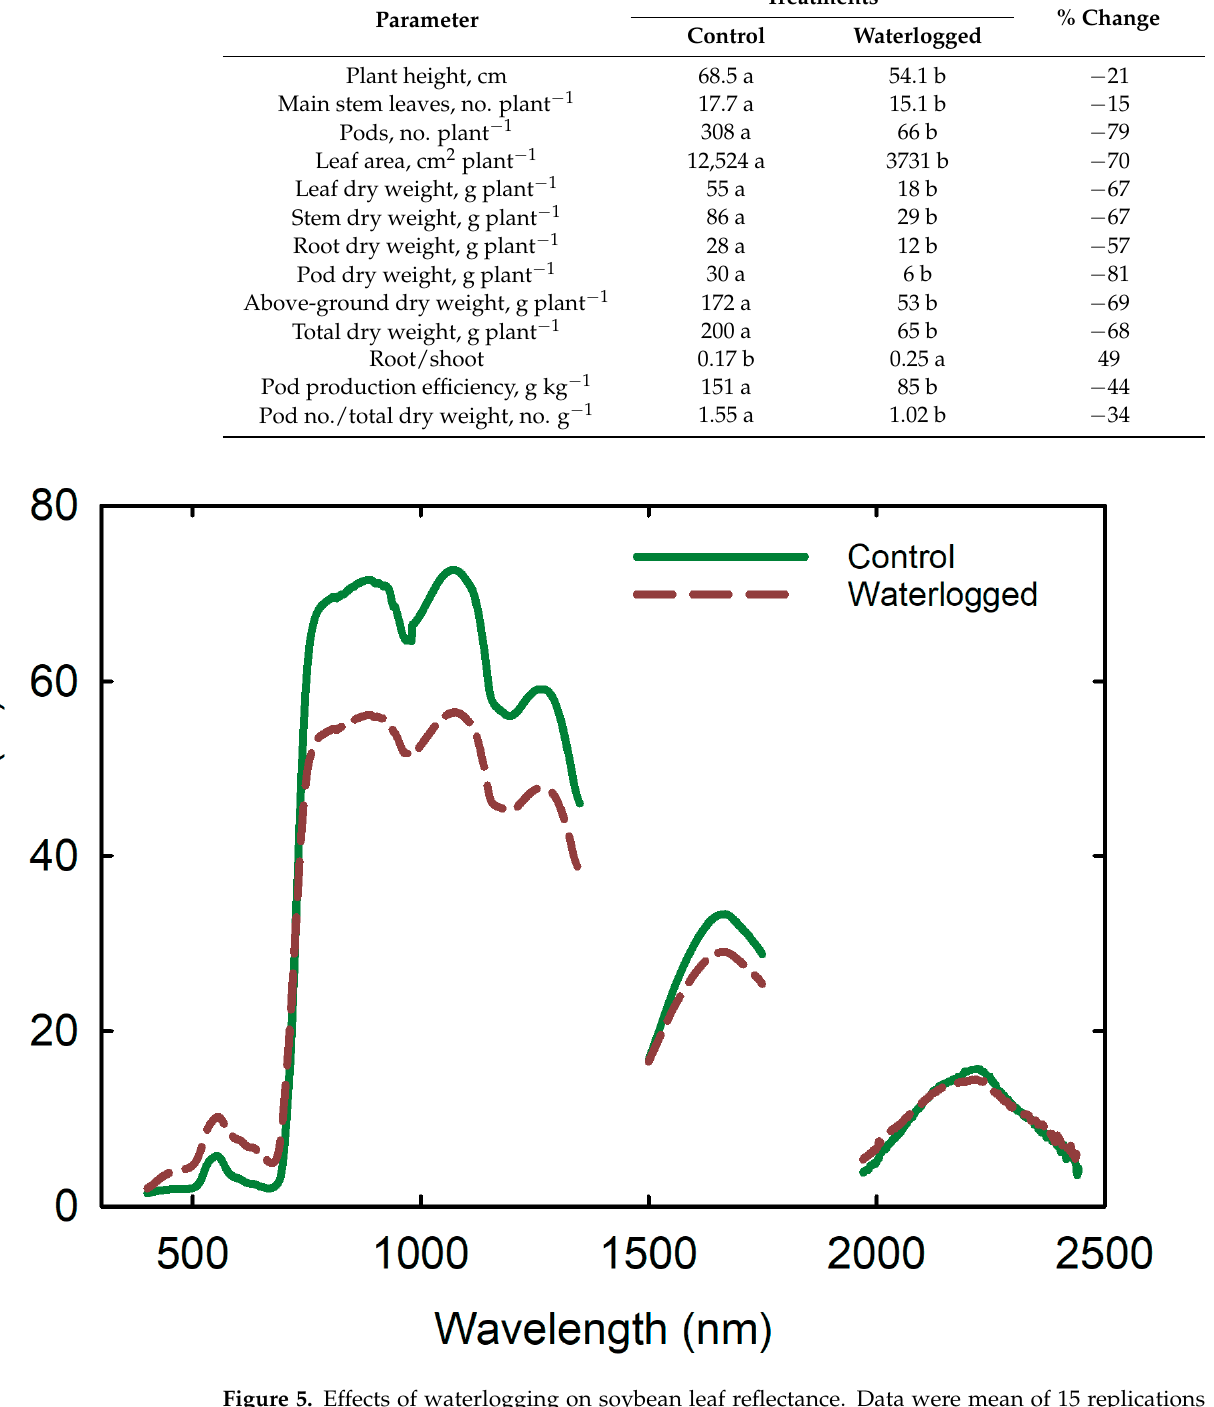
Figure 5. Effects of waterlogging on soybean leaf reflectance. Data were mean of 15 replications Figure 5 . E ff ects of waterlogging on soybean leaf re fl ectance. Data were m ean of 15 replications measured from the top-most fully expanded leaf in each plant and expressed reflectance (%) over the measured from the top-most fully expanded leaf in each plant and expressed re fl ectance (%) over wavelength the wavelength (nm).